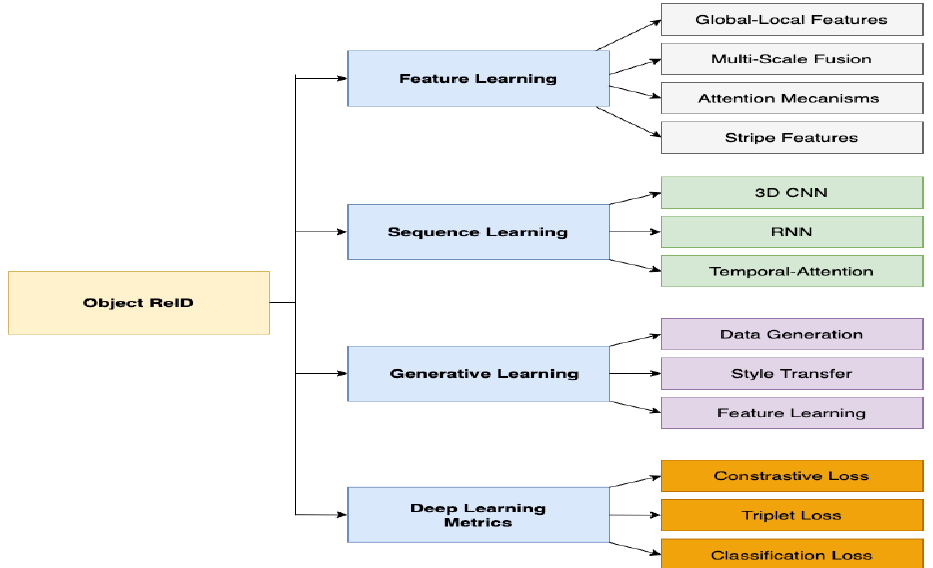
Figure 4. Deep learning-based person re-identification